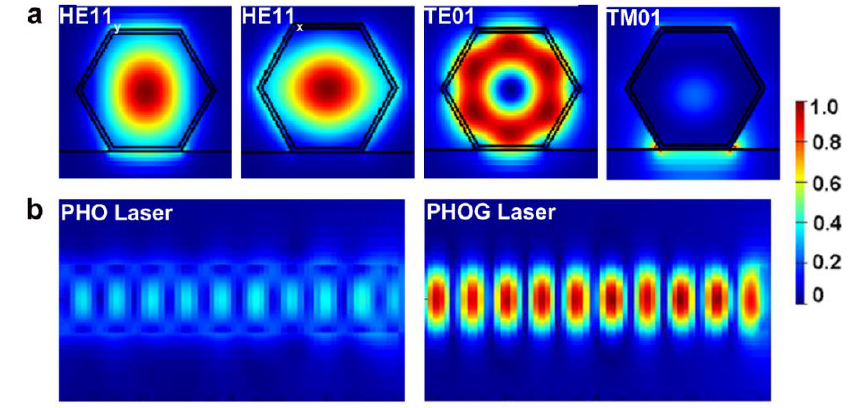
Figure 2. ( a ) The lateral electric field distribution of modes in PHO lasers. ( b ) The profile of the propagating HE11 y mode of PHO and PHOG lasers near the NW output end. The diameter is 300 nm.